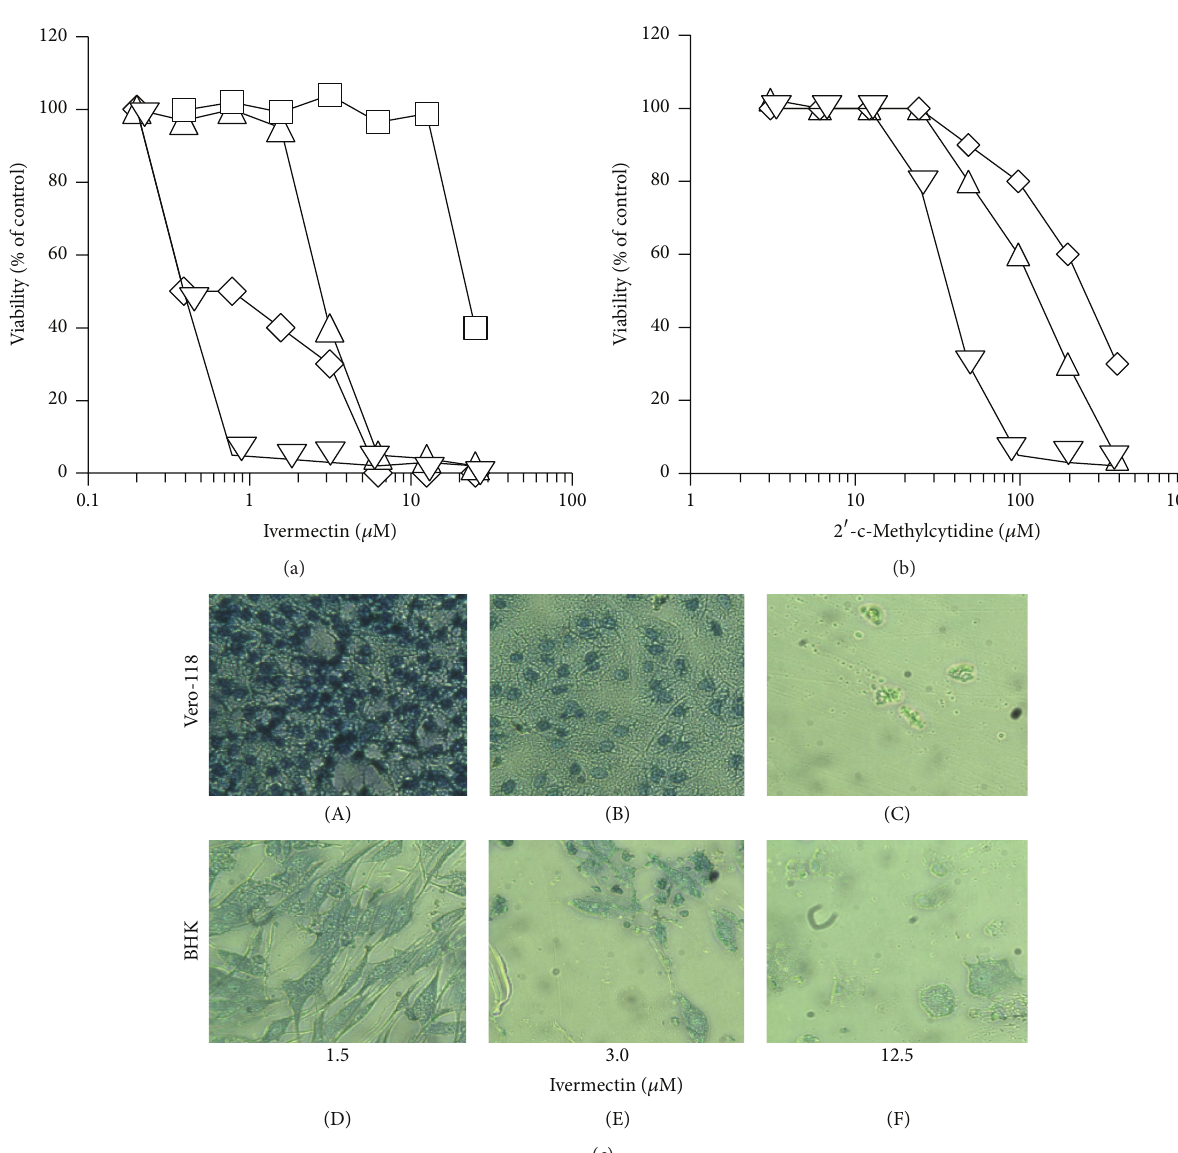
Figure 6: Effect of free ivermectin on the viability of BHK (diamonds), Vero-118 (upward triangles), Vero-F (squares), and RAW (downward triangles) cell lines (a). For comparison, in (b), the experiments are reported, conducted using 2 󸀠 -c-methylcytidine, employed as reference antiviral compound, on BHK (diamonds), Vero-118 (upward triangles), and RAW (downward triangles) cell lines. (c) Optical microphotograph of Vero-118 ((A), (B), and (C)) and BHK ((D), (E), and (F)) cells treated with the indicated concentration of ivermectin. Data represent the average of 2